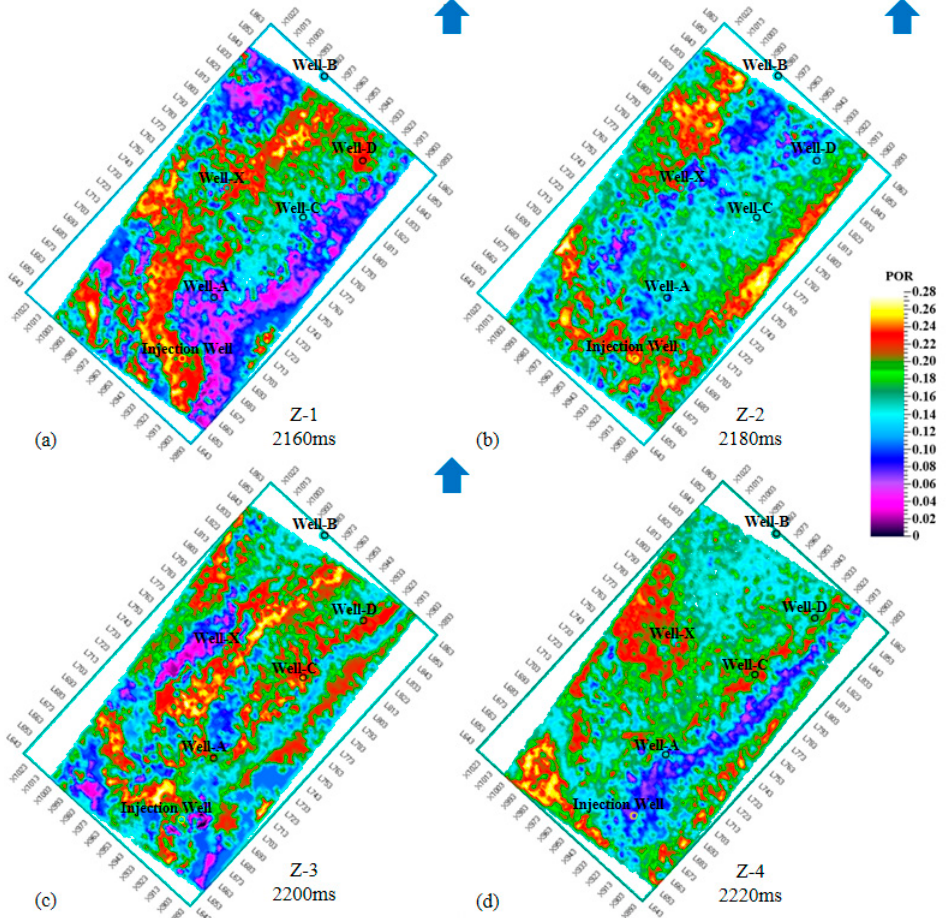
Figure 18. The time slice of porosity at various interval, ( a ) 2160 ms, ( b ) 2180 ms, ( c ) 2200 ms, and ( d ) 2220 ms.